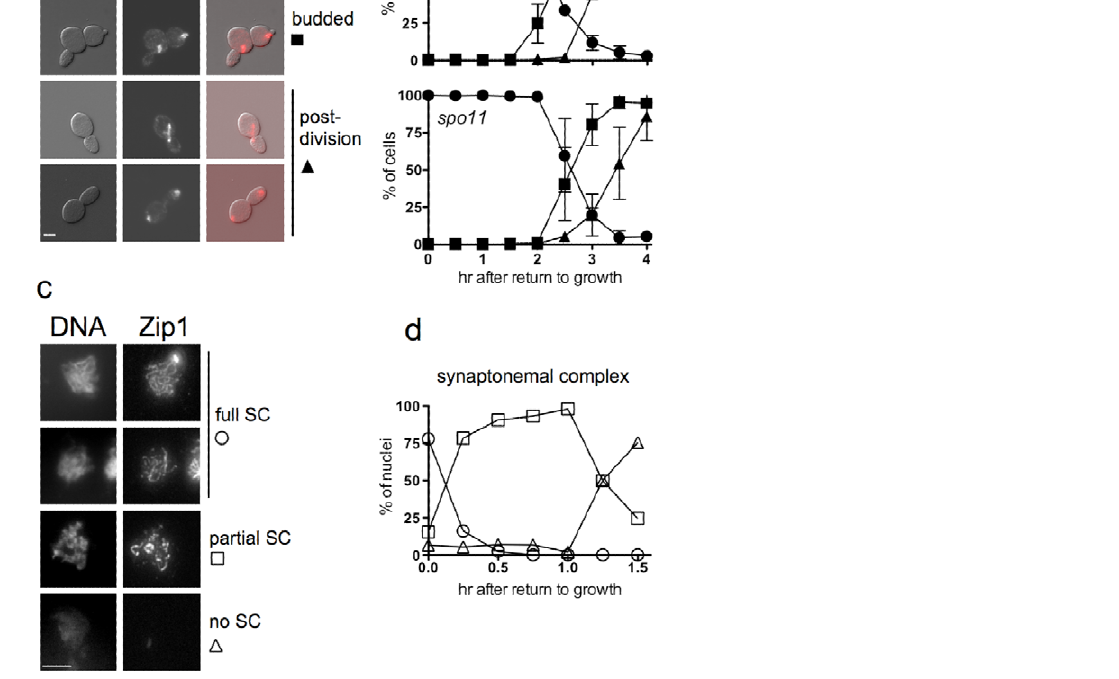
Figure 1. Cell cycle progression and SC breakdown after RTG. a. Representative images of ndt80 cells (MJL3430) at various stages of RTG, visualized by differential interference contrast (DIC) or by DAPI-staining to detect nuclei (DNA). Note that the daughter cell is elongated as compared to the round mother cell. Scale bar—4 m m. b. Time of bud emergence and nuclear division after RTG using SPO11 ndt80 D (MJL3164, top) or spo11- Y135F ndt80 D (MJL2807, bottom); the latter do not form SC or JMs. Circles – unbudded cells; squares – cells with a bud and one nucleus; triangles – cells that are undergoing or have finished nuclear division. Values for MJL3164 are from 4 independent determinations. c. SC breakdown upon RTG. Nuclei (MJL3163) were surface-spread and probed with anti-Zip1 antisera. Representative images of nuclei classified as full SC (long, continuous Zip1 lines), partial SC (discontinuous or dotty Zip1) and no SC (no Zip1 chromosomal staining) are shown together with DNA staining. Extrachromosomal Zip1 aggregates (polycomplex) were also detected as a bright-staining body. Scale bar—4 m m. d. Time of SC breakdown after RTG (MJL3163). At least 150 nuclei were scored for each time point. Circles – nuclei with full SC; squares – nuclei with partial SC; triangles – nuclei with no SC. Values are from a single